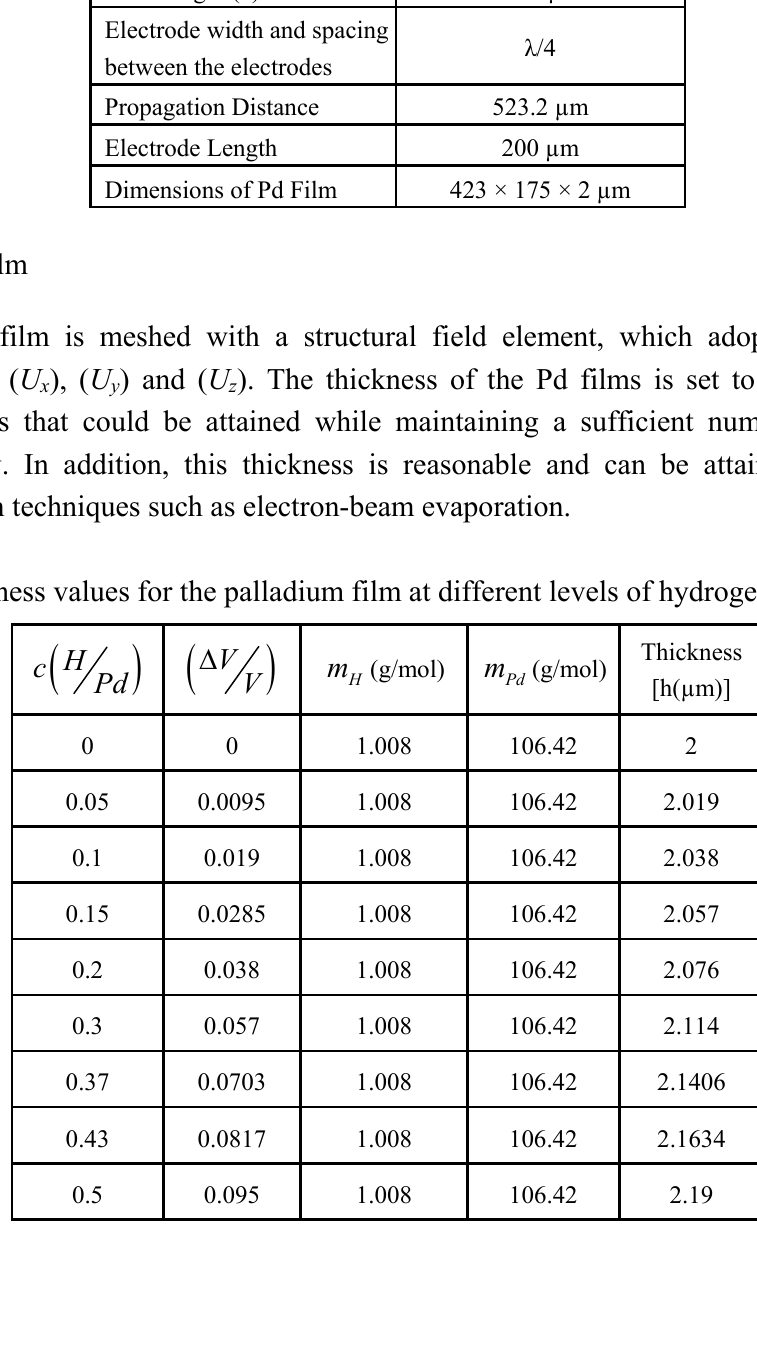
Table 4. Parameters of the YZ-LiNbO